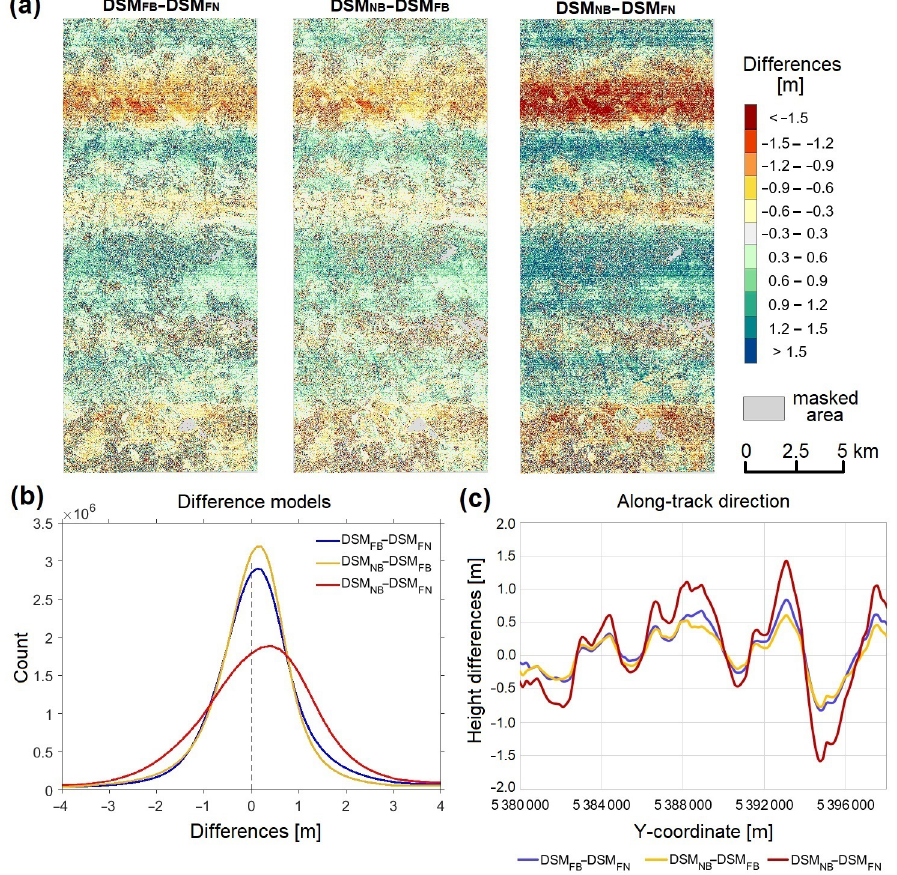
Figure 8. Differences between Pléiades pairwise DSMs: ( a ) Color-coded height differences. ( b ) Fre- quency distribution of height discrepancies. ( c ) Section profile in along-track direction with Z elevation